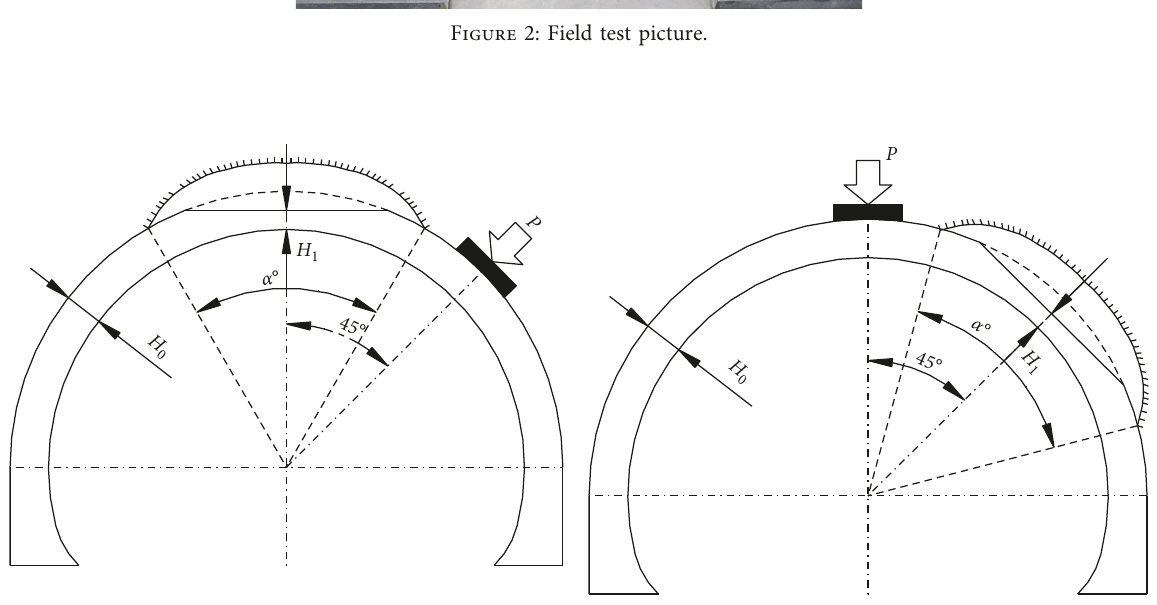
Figure 3: Diagram of set-up conditions for model test. (a) Crown void and insufficient thickness. (b) Spandrel void and insufficient